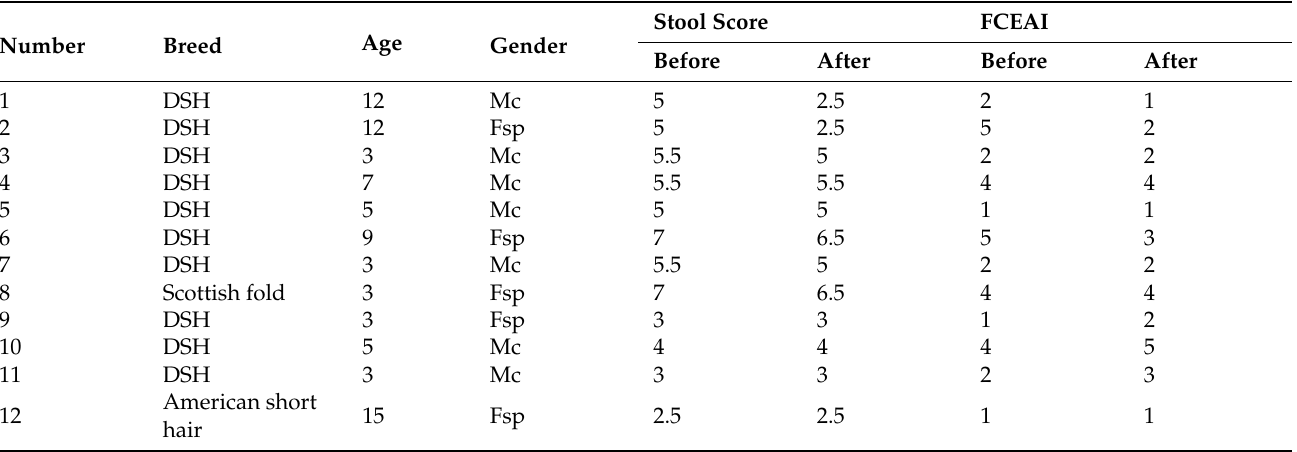
Table 1. The list of the history, stool score, and the Feline Chronic Enteropathy Activity Index (FCEAI) in cats with diarrhea (1–8) and without diarrhea (9–12) before and after the treatment of Bacillus licheniformis -fermented